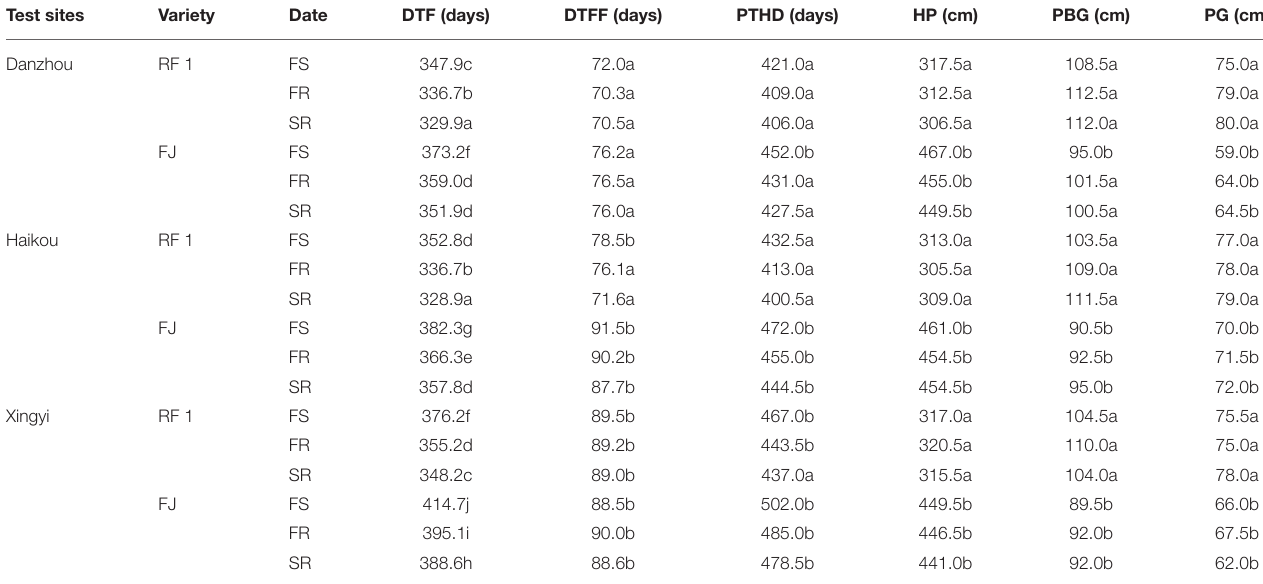
TABLE 2 | Major agronomic traits of RF1 and FJ at multiple field